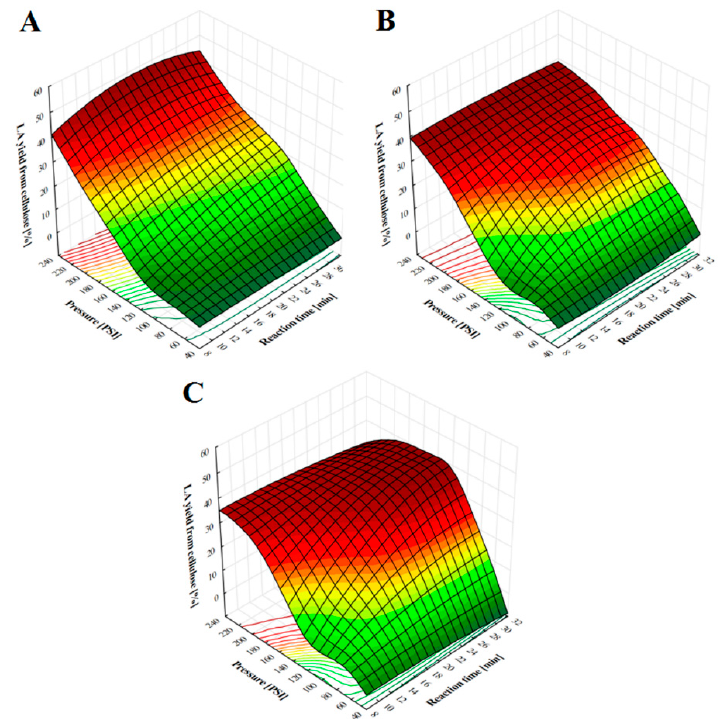
Figure 2. Response surface plot showing the effect of the interaction between pressure and reaction time of microwave-assisted conversion of pine chips on yield of production of levulinic acid from cellulose using sulfuric acid at a concentration of 1% and biomass content of 3.3% ( A ), 5% ( B ) and 10% ( C ).